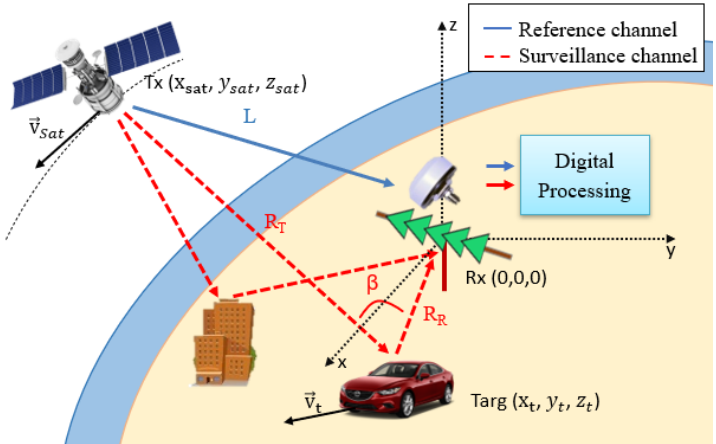
Figure 1. PR scenario based on satellite IoO, consisting of a hemispherical reference antenna to allow acquisition of all GPS signals in line of sight, and a surveillance array to acquire targets